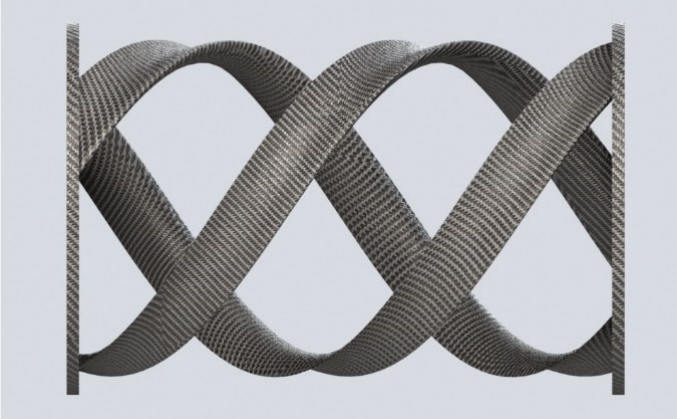
Figure 3. CAD model of the Gorlov turbine. The shaft was created by drawing a circle with a diameter of 30 mm in the top plane and extruding it by 60 mm to create the cylindrical shape. To create the sockets for the super-magnets, a plane was created at a 34 mm distance from the original top plane, and a square of 10 mm was drawn. The top line of the square coincided with the top point of the circle to ensure that it enclosed the entire circular circumference of the shaft, shown in Figure 4.